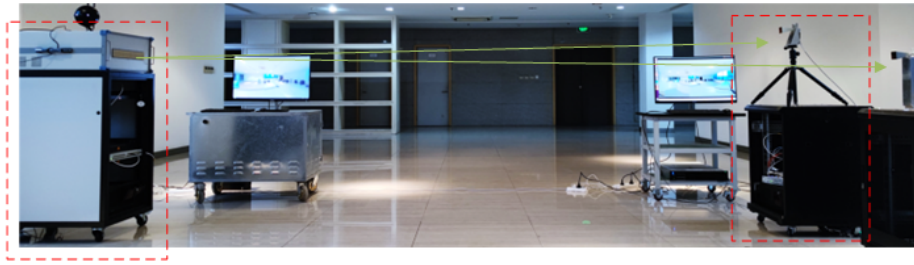
Figure 10. The indoor test